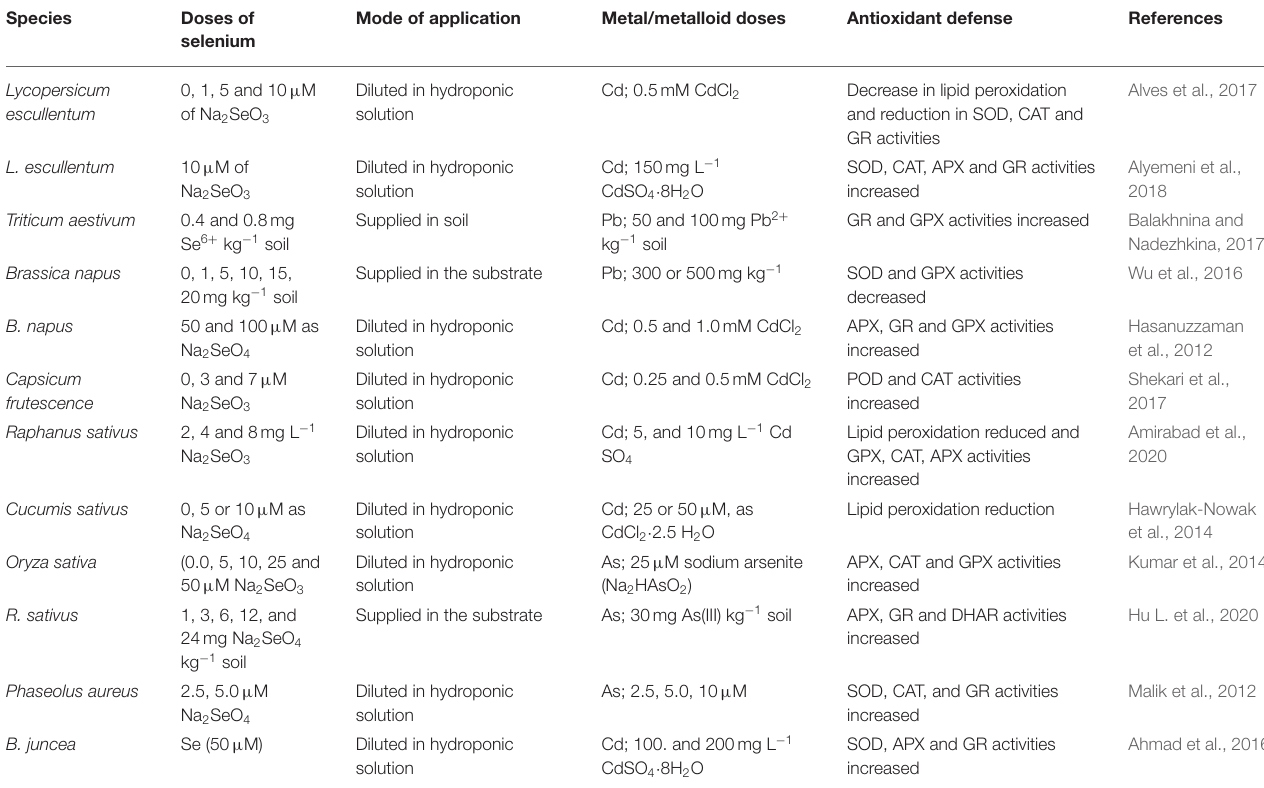
TABLE 2 | Effects of selenium application on the antioxidant defense in several species under metal/metalloid toxicity.